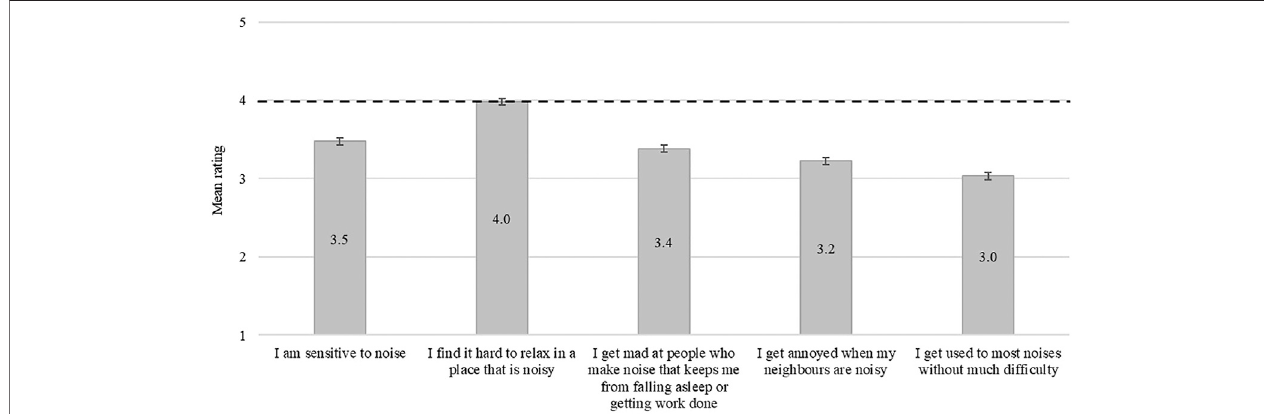
FIGURE1| Meanvaluesofthesample ’ snoisesensitivitywithrespecttospeci fi cquestions.Errorbarsrepresentthe95%con fi denceinterval(scoresfrom1,strong disagreement, to 5, strong agreement). The dashed black line corresponds to the mode value obtained for each question (i.e., rating 4).